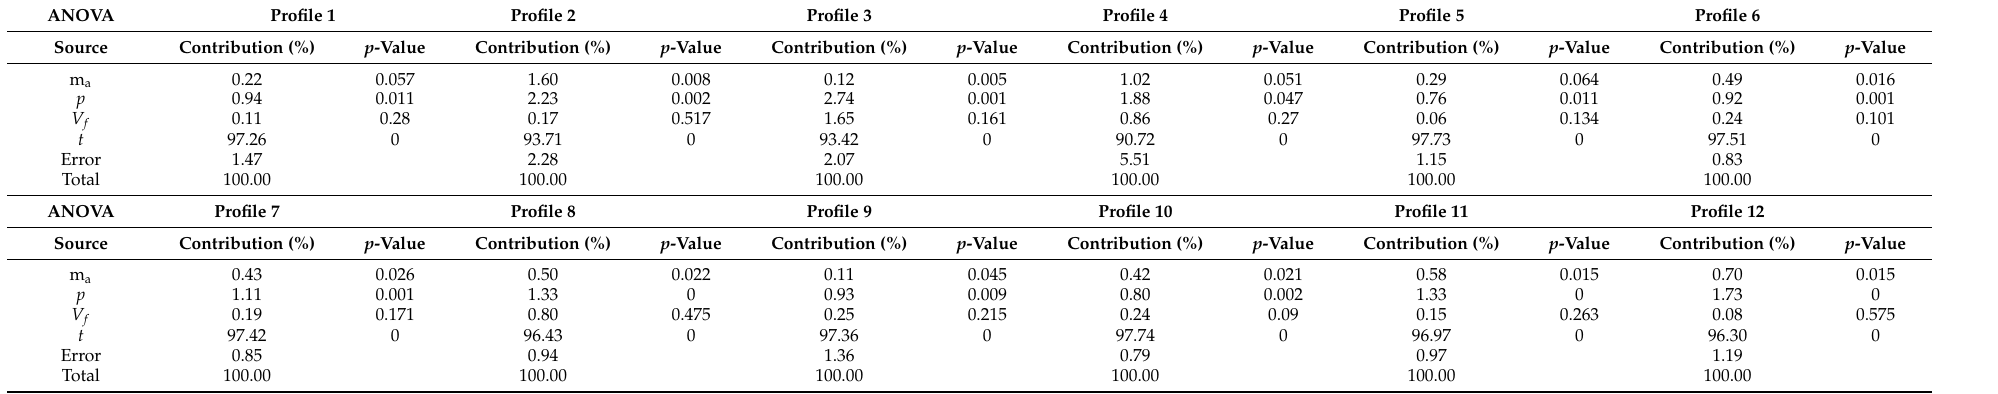
Table 7. Analysis of variance of surface roughness.